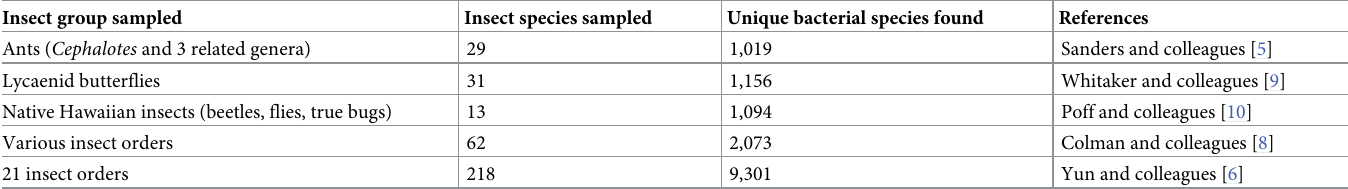
Table 1. Surveys of bacterial diversity among insect species. LEA incorrectly estimated that a genus of 130 ant species ( Cephalotes ) hosts only 40 bacterial species and subsequently assumed that all animal genera have the same low number of bacterial species. These broad surveys of bacterial species among insects suggest that many insects (including Cephalotes ) host much larger numbers of bacterial species. Insect group sampled Insect species sampled Unique bacterial species